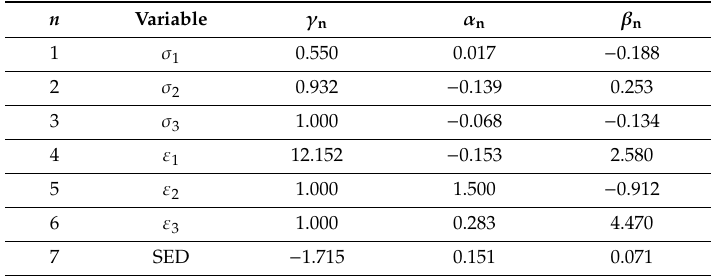
Table 3. Model weights of FDMP model for NBR tests. Initial data from [45].